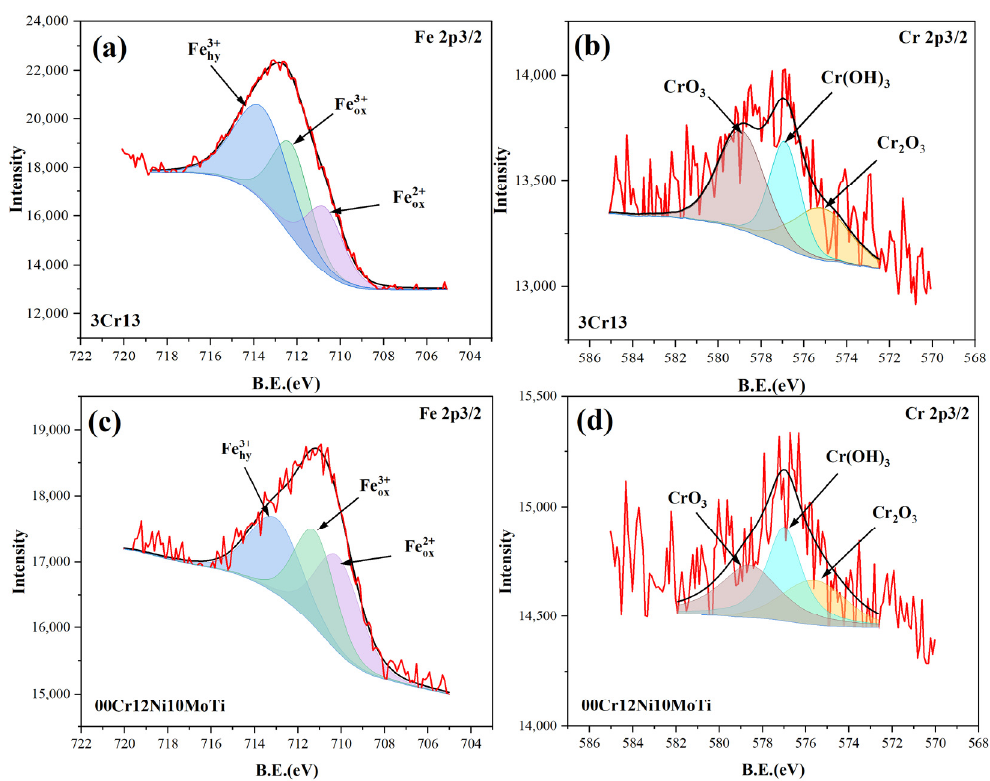
Figure 5. XPS spectra of corrosion products of two stainless steels corroded for two years: ( a , b ) 3Cr13, ( c , d ) 00Cr12Ni10MoTi.